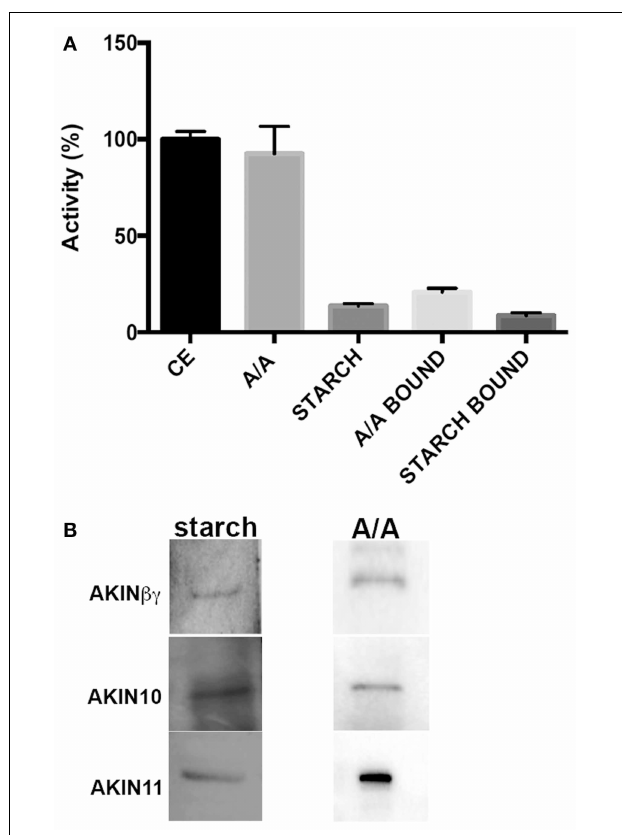
FIGURE 4 | Effect of A/A and starch on SnRK1 activity. (A) SnRK1 kinase activity measured under normal conditions (CE), with 0.4mg of A/A in the reaction mixture (A/A), with 0.5mg of starch (STARCH) and using the protein-A/A complex (A/A bound) and the protein-starch complex (STARCH bound) as protein source. Specific activity for the control was 2.04 ± 0.08nmol/min/mg. (B) Western blot analysis of the proteins extracted from the starch (starch) and from the A/A complexes